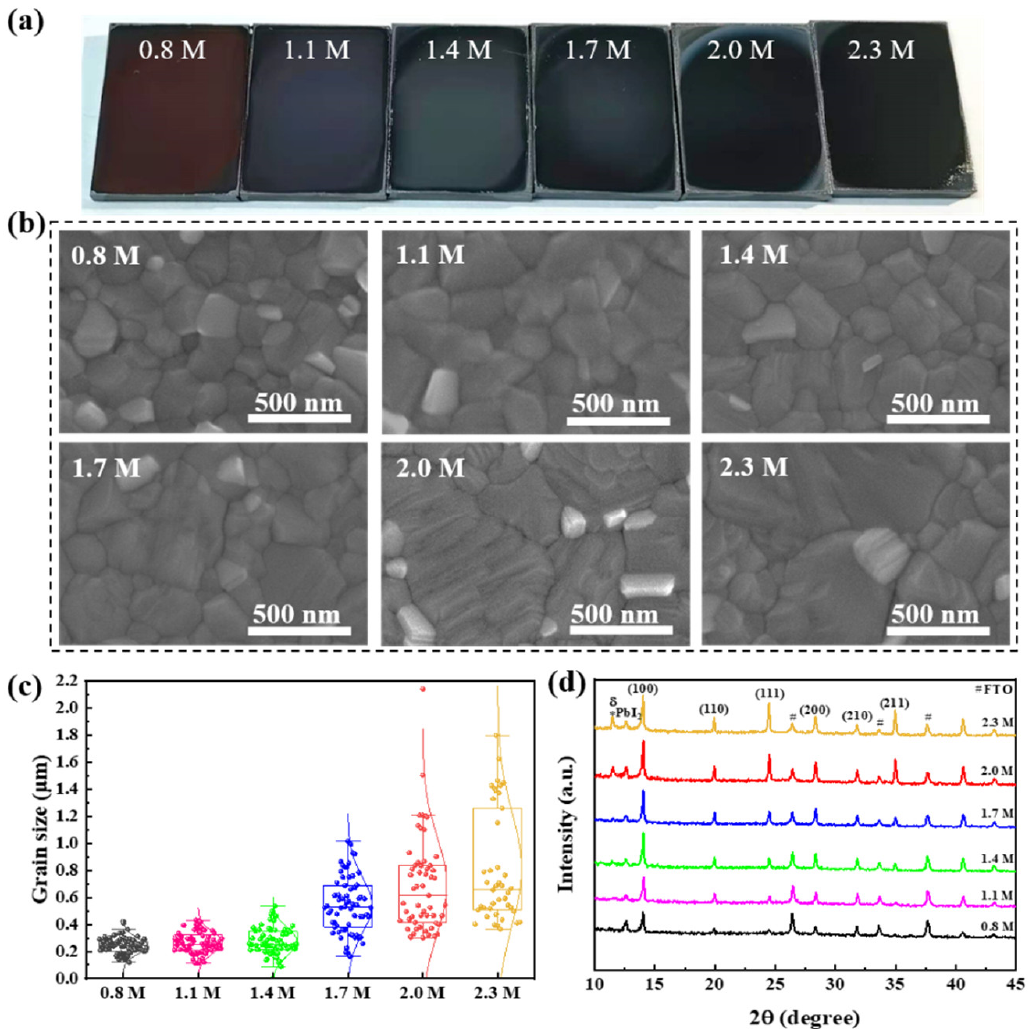
Figure 1. Morphology and crystalline of perovskite films. The perovskite precursor concentrations of perovskite films are 0.8 M, 1.1 M, 1.4 M, 1.7 M, 2.0 M, and 2.3 M, respectively. ( a ) Photographs by camera, ( b ) Top-view SEM images in 50.0 k× magnification , ( c ) Statistical analysis of the grain size in the SEM visual field with same size (2.6 × 1.9 μm), ( d ) XRD patterns (# denotes FTO and * denotes yellow δ phase).